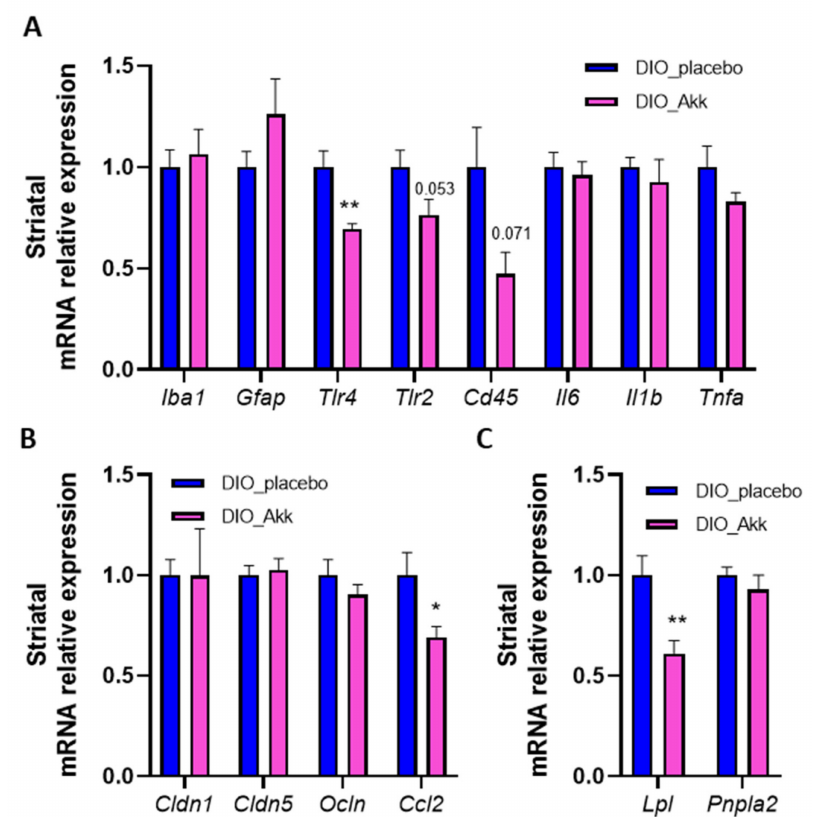
Figure 4. A. muciniphila administration reduces mesocorticolimbic markers of inflammation and BBB permeability associated with obesity and lowers striatal Lpl expression. ( A ) Striatal mRNA relative expression of ionized calcium-binding adapter ( Iba1 ), glial fibrillary acidic protein ( Gfap ), toll-like receptor 4 ( Tlr4 ), toll-like receptor 2 ( Tlr2 ), cluster of differentiation 45 ( Cd45 ) interleukin 6 ( Il6 ), interleukin 1 beta ( Il1b ), tumor necrosis factor alpha ( Tnfa ); and ( B ) claudin–1 ( Cldn1 ), claudin–5 ( Cldn5 ), occludin ( Ocln ), C-C chemokine ligand 2 ( Ccl2 ); and ( C ) lipoprotein lipase ( Lpl ) and patatin- like phospholipase domain containing 2 ( Pnpla2 ) measured by real-time qPCR in DIO mice treated with placebo (DIO_placebo) and A. muciniphila (DIO_Akk). ( n = 5–10/group). Data are shown as mean ± SEM. p -values were obtained after unpaired Student’s t -test or non-parametric Mann– Whitney test. *: p -value < 0.05; **: p -value < 0.01 between DIO_placebo vs.